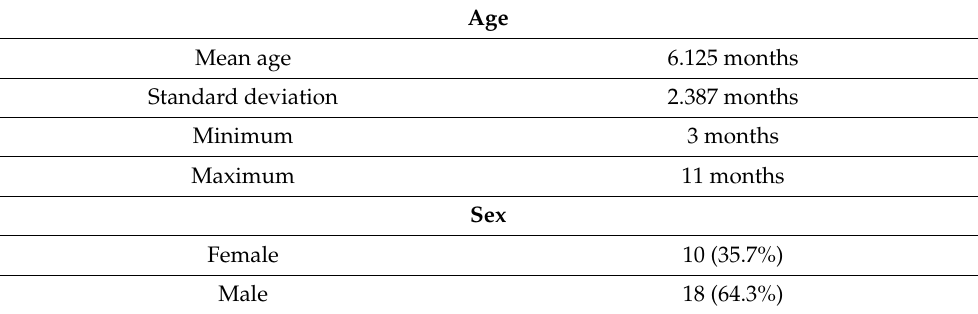
Table A2. Sociodemographic characteristics of